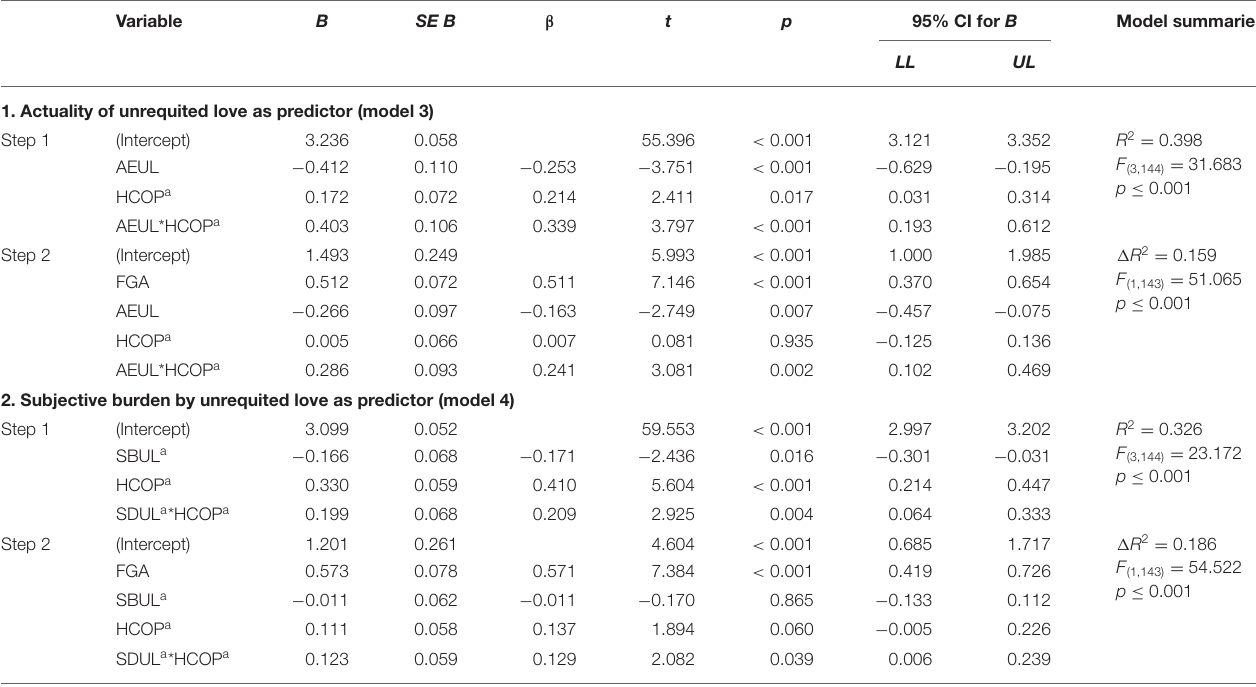
TABLE 4 | Summary of hierarchical regression analyses predicting self-esteem from burden of unrequited love (two different operationalizations) and Humorous Change of Perspective (measured by HCOP-Scale). Variable B SE B β t p 95% CI for B Model